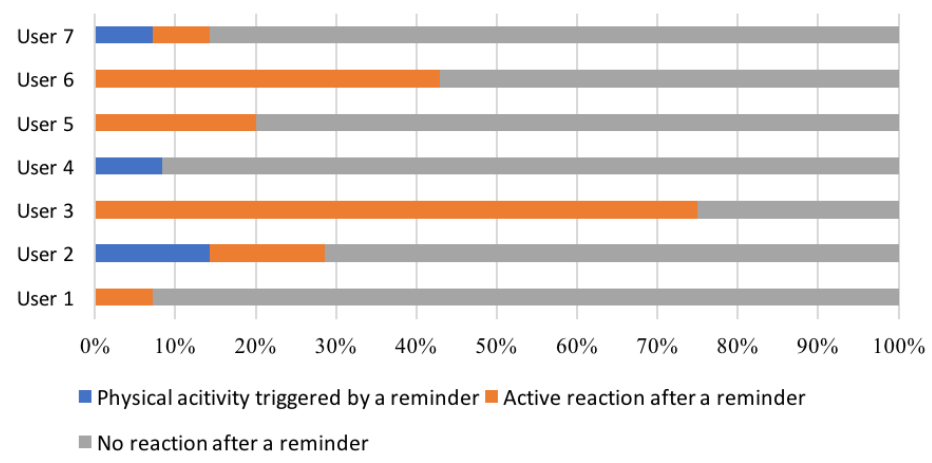
Figure 4. The reaction behaviors of all 7 users after receiving reminders from the PAUL app.